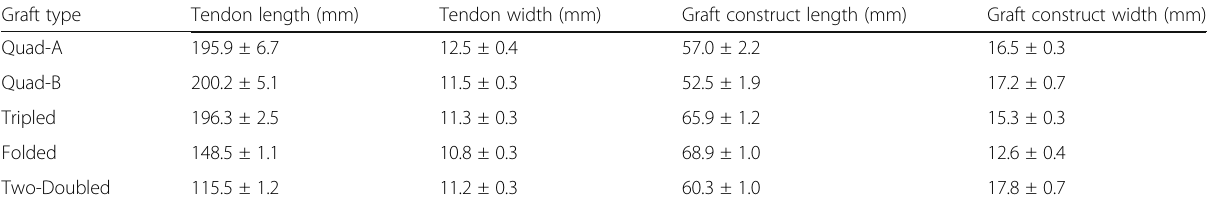
Table 1 Dimensions of porcine extensor tendons and ACL/PCL Graft constructs; n = 10 in each graft group Graft